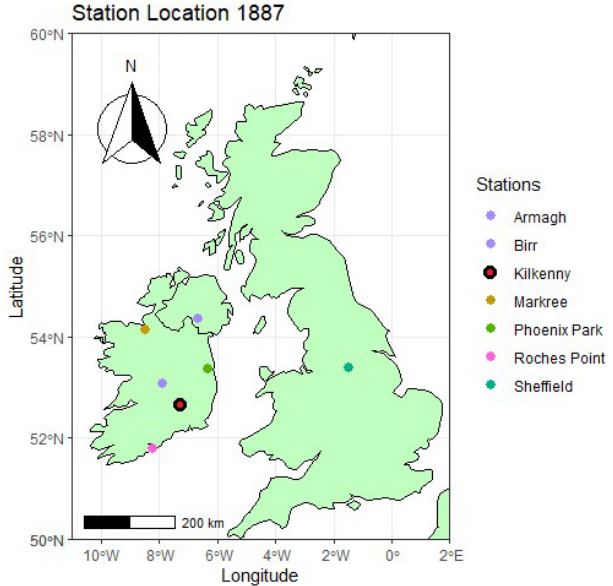
Figure 2. Location of the seven stations in Ireland and England used in this study to assess the reliability of the reported Kilkenny record. The green marker shows the location of the Kilkenny sta- tion. Station selection is based upon availability over the period of the Kilkenny record high-temperature